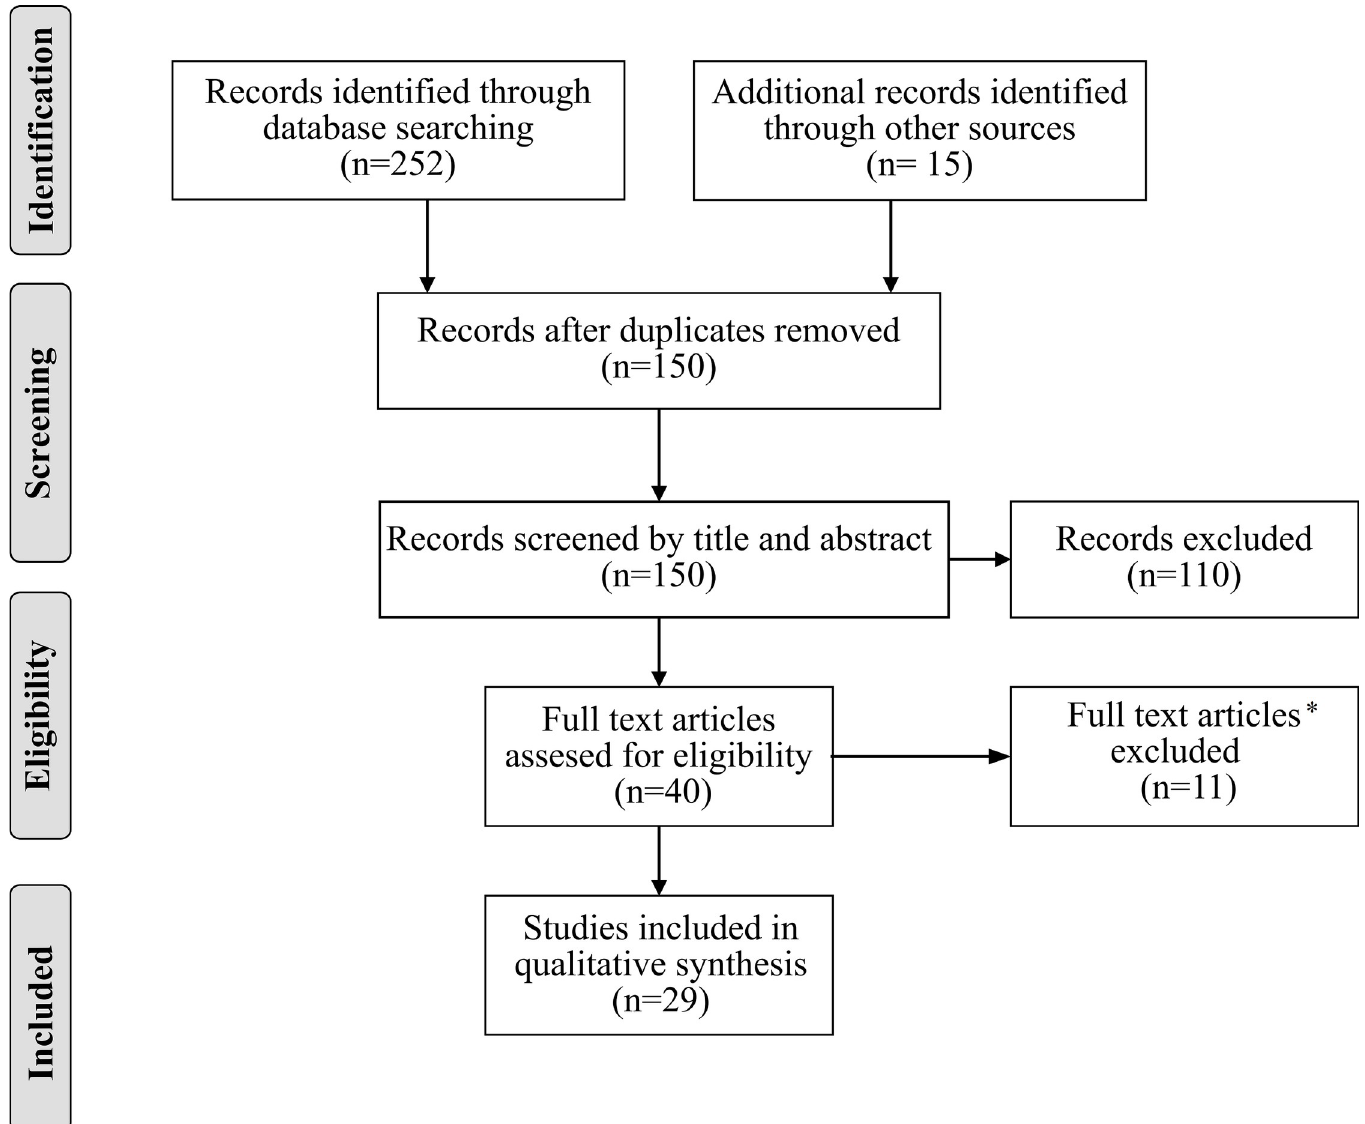
Fig 1. The flow diagram represents the studies selection process. � Six studies were excluded since the full text was not available and five were excluded since they did not measure CFT.